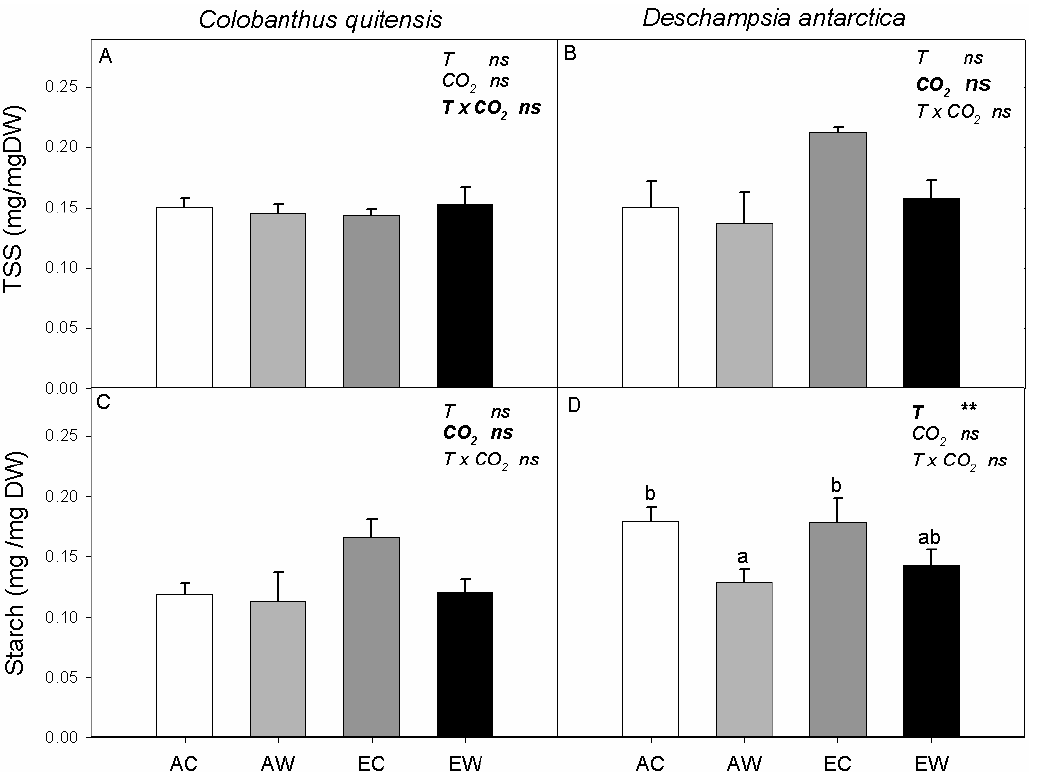
Figure 3. Total soluble sugars (TSS) and starch for C. quitensis ( A , C ) and D. antarctica ( B , D ). Treatments correspond to AC (ambient CO 2 , control thermoperiod; white bar empty), AW (ambient CO 2 , warming thermoperiod; white bar hashed), EC (elevated CO 2 , control thermoperiod; grey bar), and EW (elevated CO 2 , warming thermoperiod; grey bar hashed). Values are means ± SEM ( n = 5). For each graph, the effect of thermoperiod (T), CO 2 environment (CO 2 ), and the interaction of thermoperiod and CO 2 (T x CO 2 ), with ns indicates no significance difference, * indicates p ≤ 0.05, ** indicates p ≤ 0.01 , and *** indicates p ≤ 0.001. The factor with the largest effect size is indicated in bold.